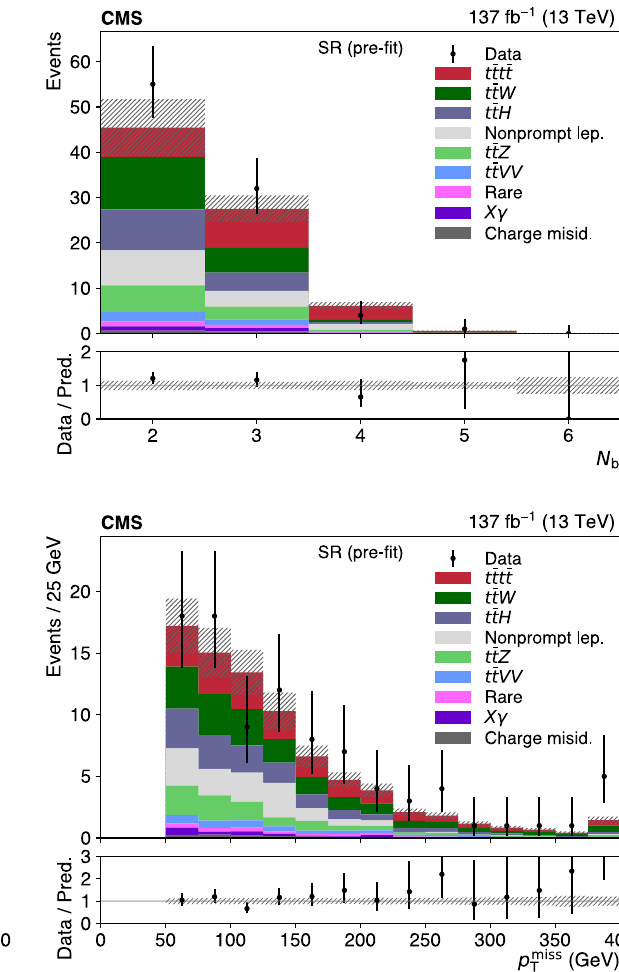
The tttt signal assumes the SM cross section from Ref. [1]. The lower panels show the ratios of the observed event yield to the total prediction of signal plus